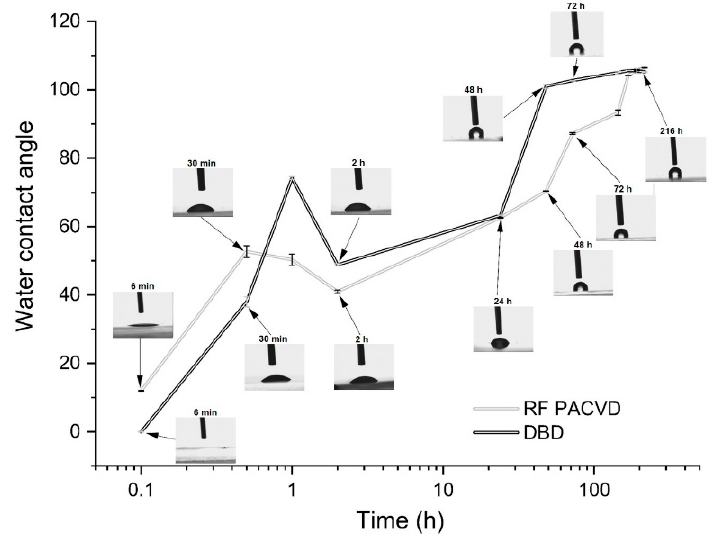
Figure 2. Changes in the water contact angle with time after one-minute plasma treatment in air using the DBD and RF PACVD techniques.